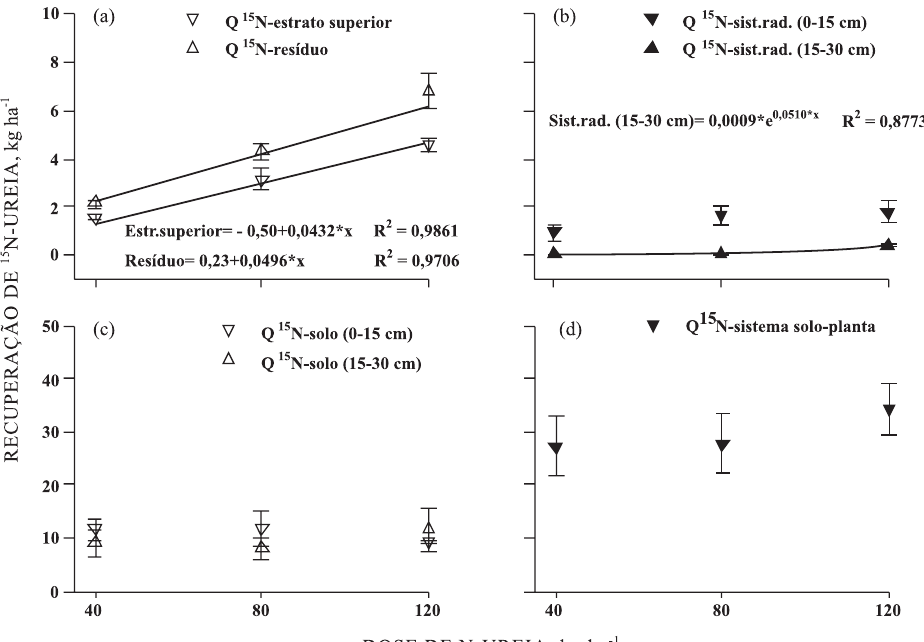
4. Recuperação de 15 N-ureia (kg ha -1 ) nos componentes da pastagem de capim-tanzânia